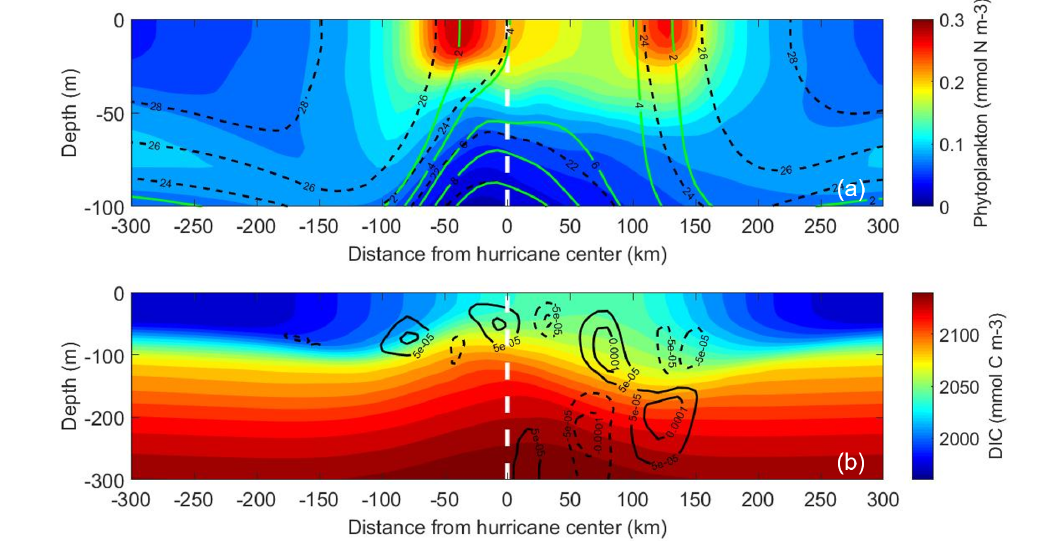
Figure 2. Comparison of the change in surface properties between all combinations of translation speed and intensity. Values were computed by averaging spatially over a subregion defined by 1000 km to 3116 km, and 1200 km to 1800 km (a common area affected by all translation speeds). The difference between the last time step and the first time step was calculated. Dots indicate the calculated values. Overlaid is a third-order polynomial fitting (color shading) of the data points, extrapolated to translation speeds 2.5 through 10 m s − 1 for Categories 1–5. Six properties are shown: ( a ) ∆ SST ( ◦ C), ( b ) ∆ DIC (mmol m − 3 ), ( c ) ∆ NO 3 (mmol m − 3 ), ( d ) ∆ chlorophyll (mg m − 3 ), and ( e ) ∆ pCO 2 w ( µ atm).